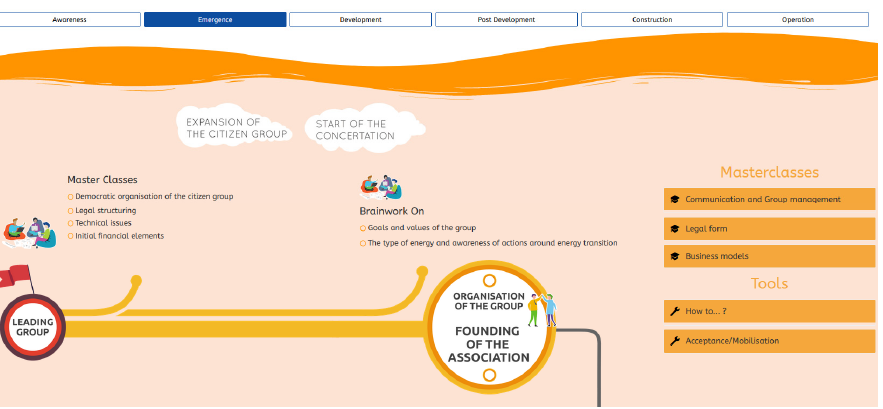
Figure 7. Progress Tool result for a project in the emergence phase showing relevant masterclasses and tools.